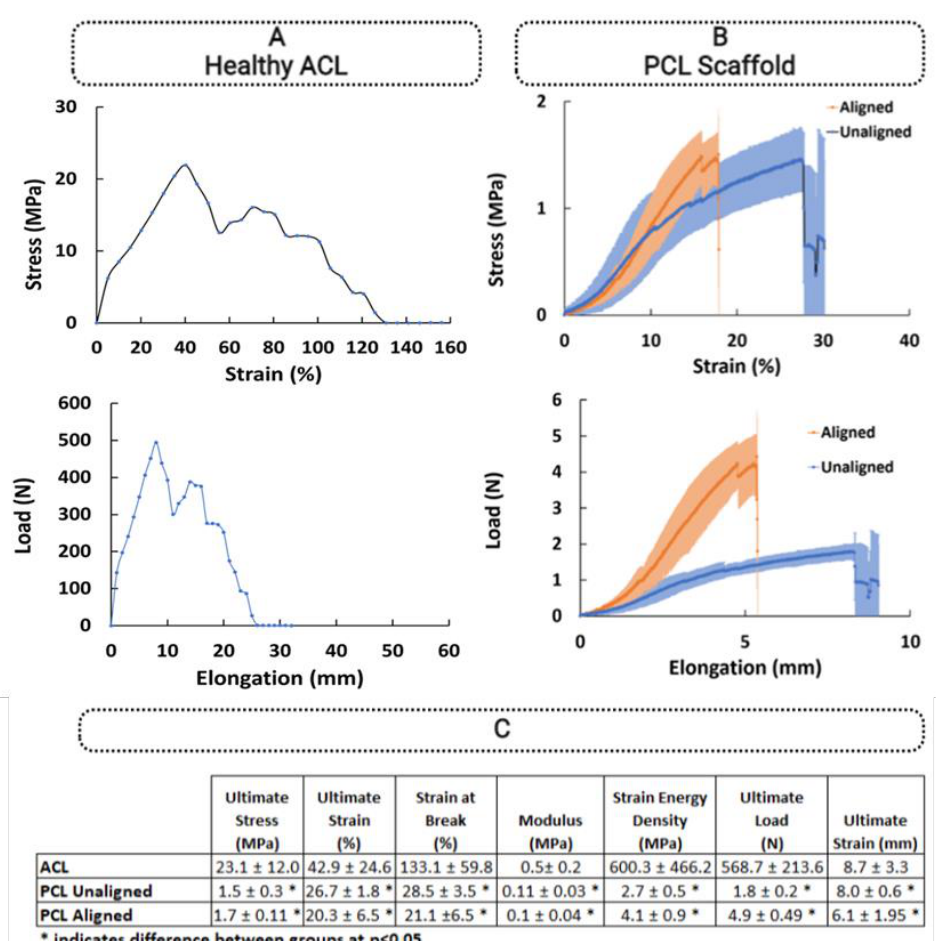
Figure 7. Mechanical properties of native ACL tissue and PCL constructs. ( A ) Healthy ACL tissue, ( B ) PCL constructs, and ( C ) descriptive statistics. * indicates significant difference at p < 0.05. Error bars represent standard deviation.